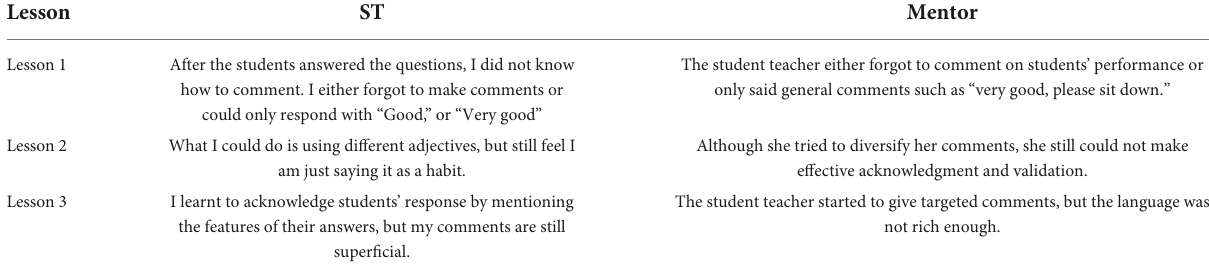
TABLE 5 The excerpts of interview data about